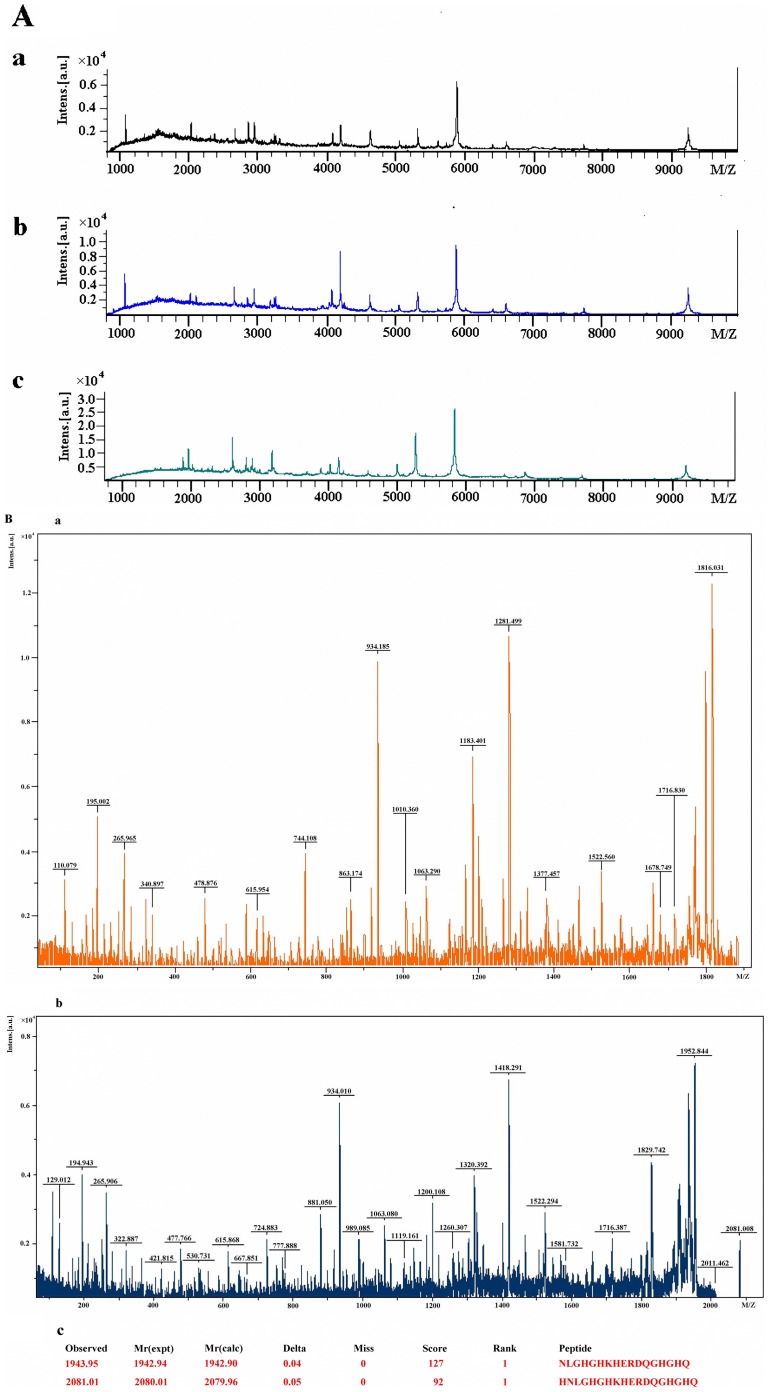
Representative mass spectra of different serum samples and identification of peptides.
A: Representative mass spectra of control serum (a), serum from a patient with ACA (b), and serum from a patient with CRC (c). B: MALDI/MS/MS spectra of the ions at m/z 1943.95 (a) and m/z 2081.01 (b). Panel c provides the results from the Mascot database search, which indicated both peaks correspond to kininogen-1.